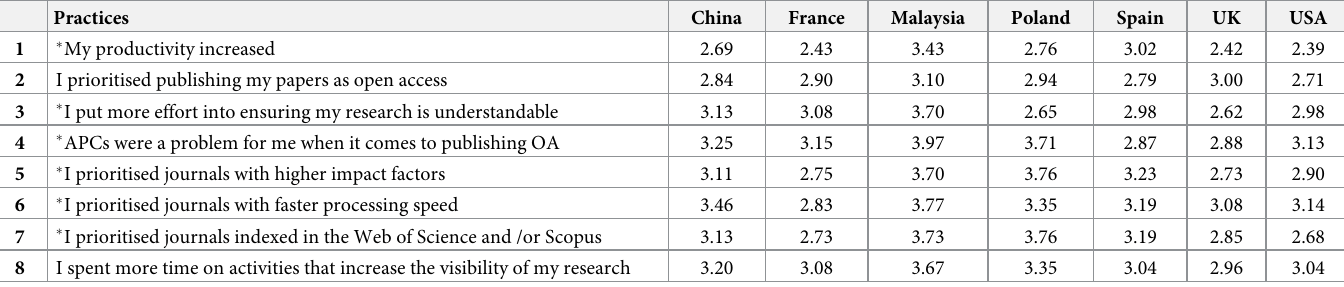
Table 8. Country differences for publishing practices.